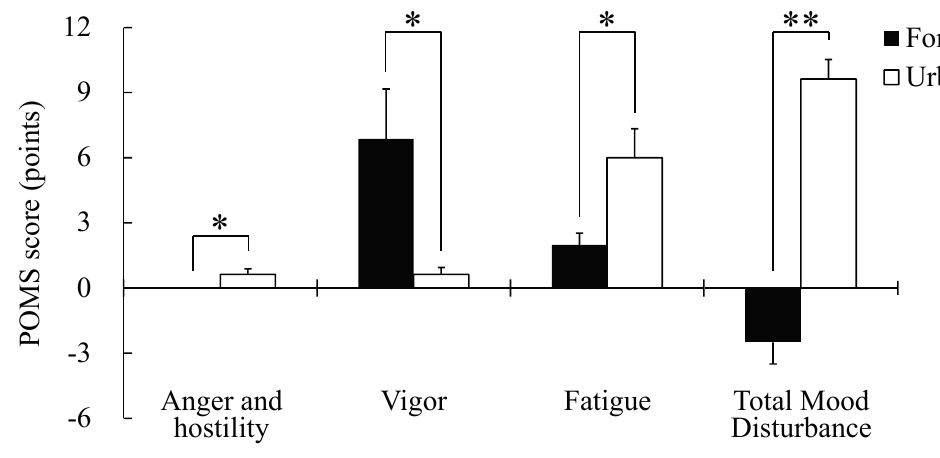
Figure 4. Comparison of subjective scoring for “comfortable”, “natural”, and “soothed” feeling between forest and urban areas. N = 8, mean ± SE, * p < 0.05; ** p < 0.01, determined by Wilcoxon signed-rank test.